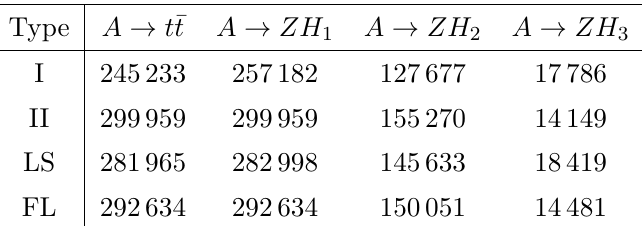
Table 25 . Number of parameter points available for the analysis in the individual OS decay channels of A ( H 1 is